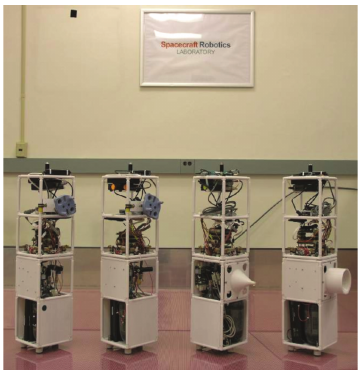
Figure 1: Multispacecraft testbed at the Spacecraft Robotics Laboratory of the Naval Postgraduate